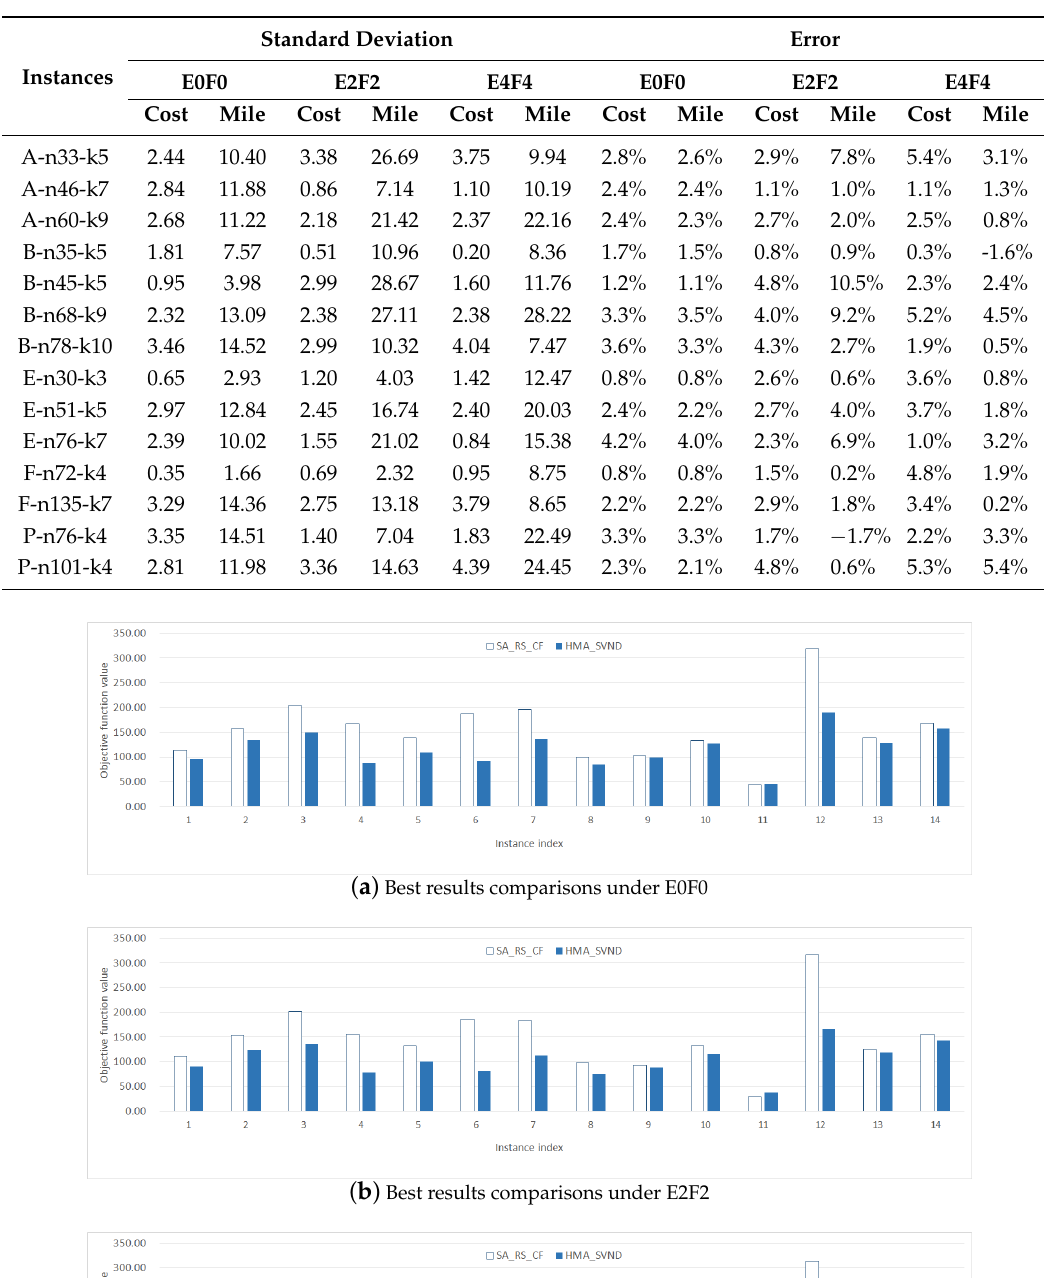
Table 4. Standard deviation and Error on tested instances.